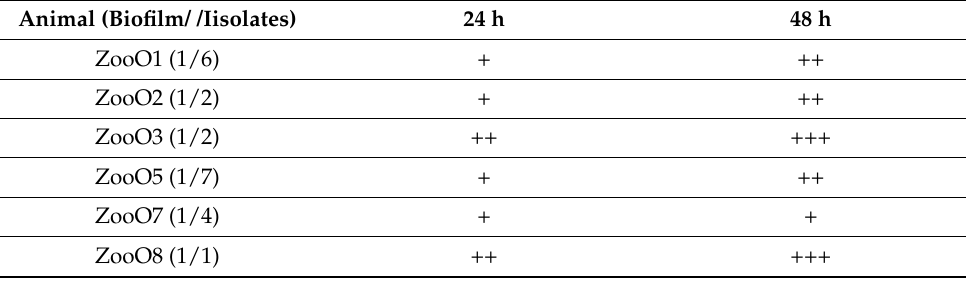
Table 1. Description of the biofilm formation ability of the isolates (six from twenty-two) according to the classification proposed by Stepanovi ć and colleagues. Legend: (0) OD ≤ 2×ODc—non-biofilm producer; (+) ODc < OD ≤ 2 × ODc—weak